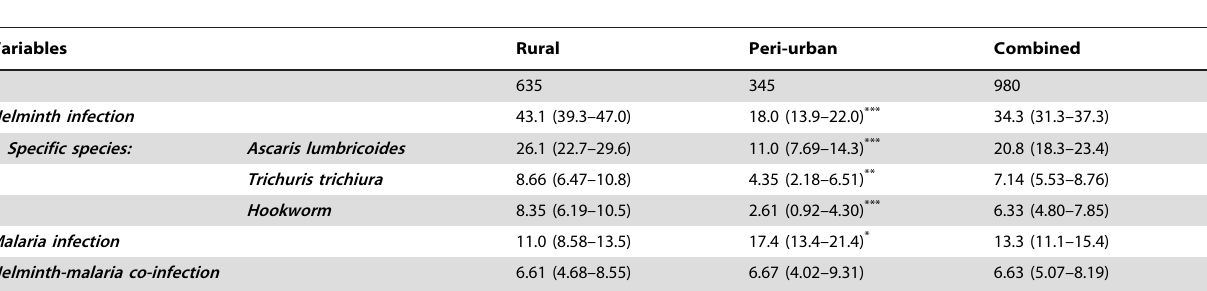
Table 1. Prevalence of helminth and malarial infections in rural and peri-urban populations.